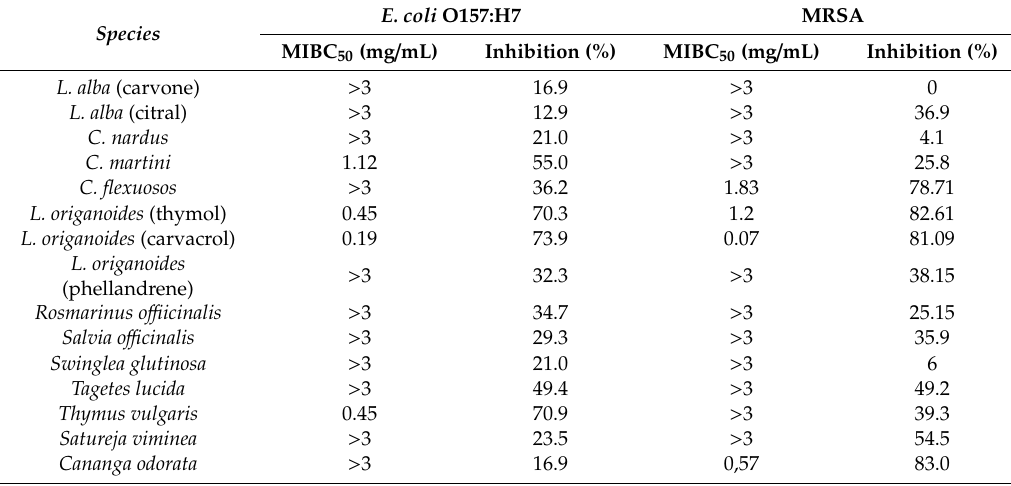
Table 3. E ff ect of di ff erent EOs on the formation of biofilm in E. coli O157:H7 and MRSA. The inhibition percentage was calculated with respect to the control group and corresponds to the highest concentration of EO